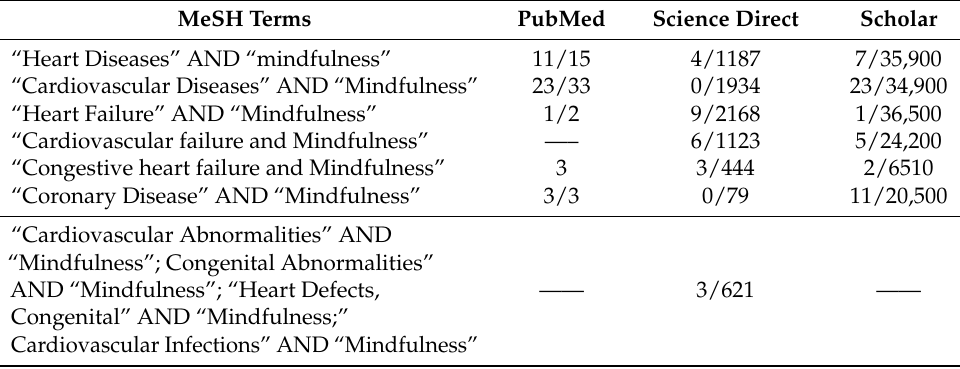
Table 1. Keywords and example of Search